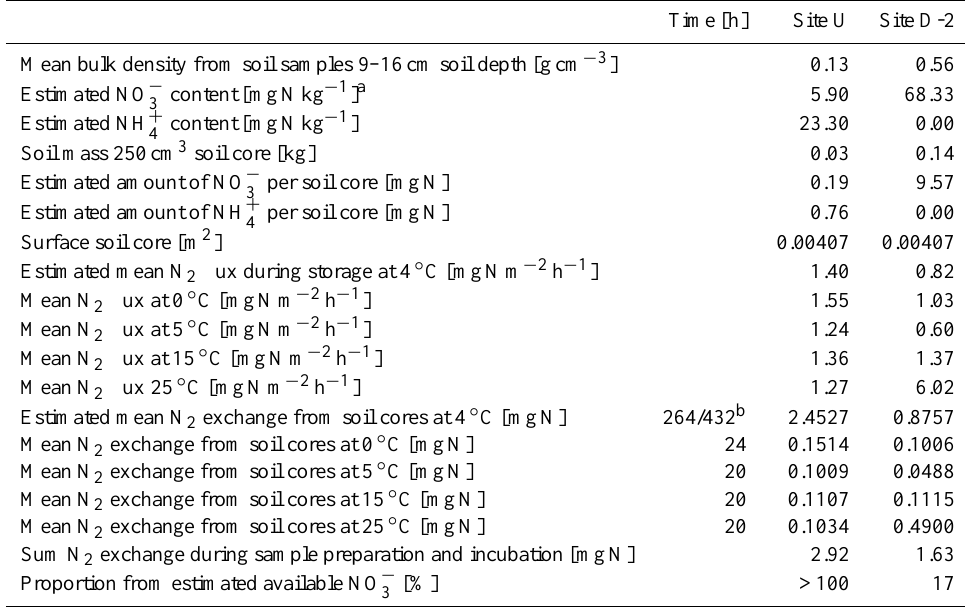
consumption during sample storage and incubation time at 100% 3